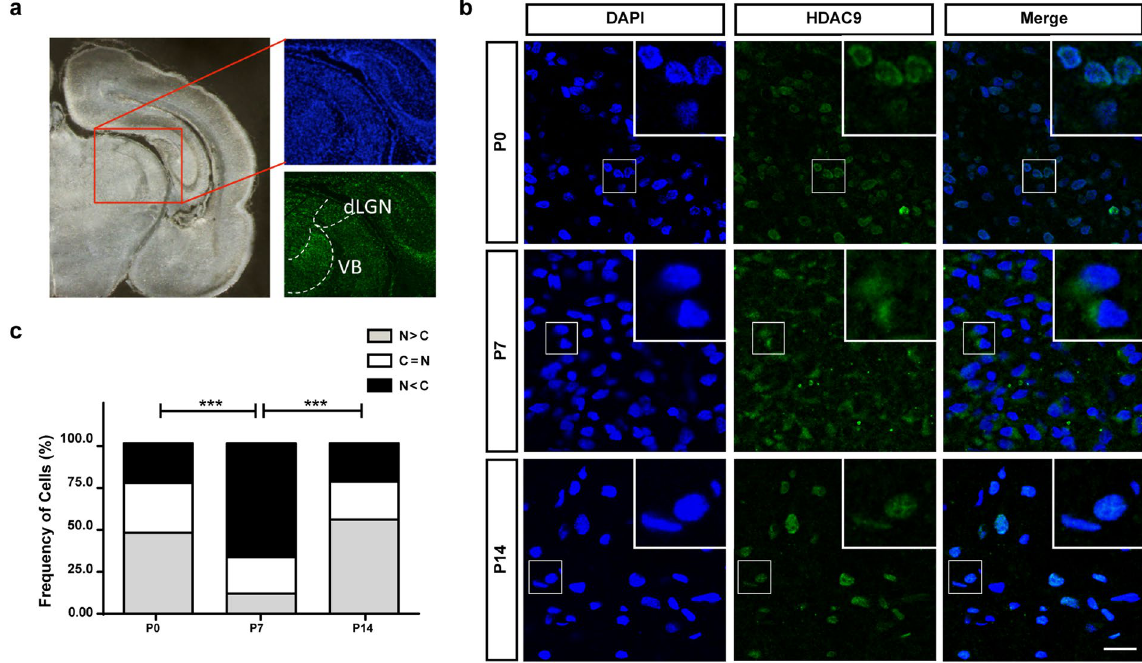
Figure 1. HDAC9 translocation in the developing rat thalamus. ( a ) Locations of dLGN and VB are shown in a coronal section. ( b ) P0, P7 and P14 rat thalami were analyzed after immunohistochemistry against HDAC9. HDAC9 export from the nucleus can be observed by the end of the first postnatal week. Scale bar: 35 μ m Green: HDAC9. Blue: DAPI. ( c ) Distribution of the cells according to the ratio of HDAC9 signal intensity in the cytoplasm normalized to its nuclear intensity. Cells in which the cytoplasm/nuclear signal ratio was below 0.9 were considered as having a nuclear signal (N > C). Cells that the average signal in the nucleus and the cytoplasm did not differ in more than 10% (i.e. ratios between 0.9 and 1.1) were categorize as N = C. Cells in which the signals in the cytoplasm were considerably higher than in the nucleus (ratios above 1.1) were categorized as N < C. N = 958, 2029 and 808 cells from 3 different animals for P0, P7 and P14, respectively. Statistical analysis by overall Chi-square (Chi = 898.7, with 4 degrees of freedom, p < 0.0001) followed by pairwise Chi-square with Bonferroni correction. *** p <